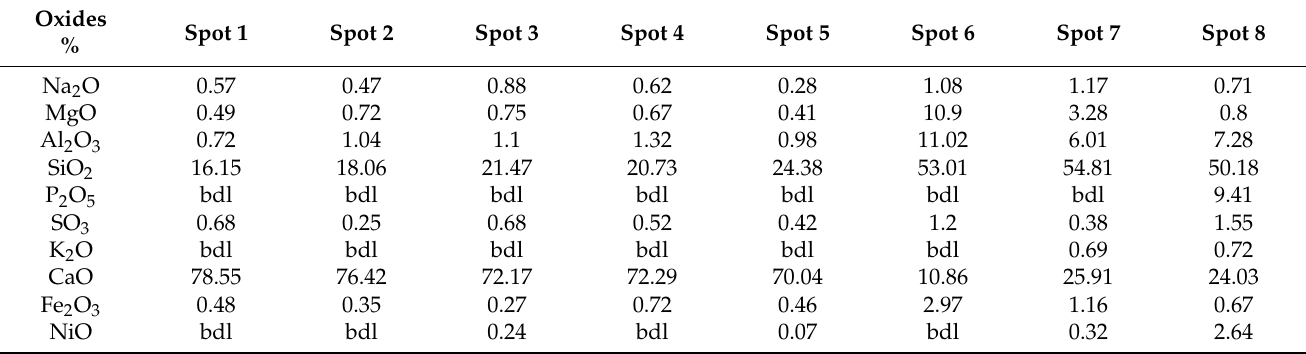
Table 7. Microchemical spot analyses (spot 1–8) of binder areas of bedding mortars from the Trebbio castle tower (Mugello, Florence).